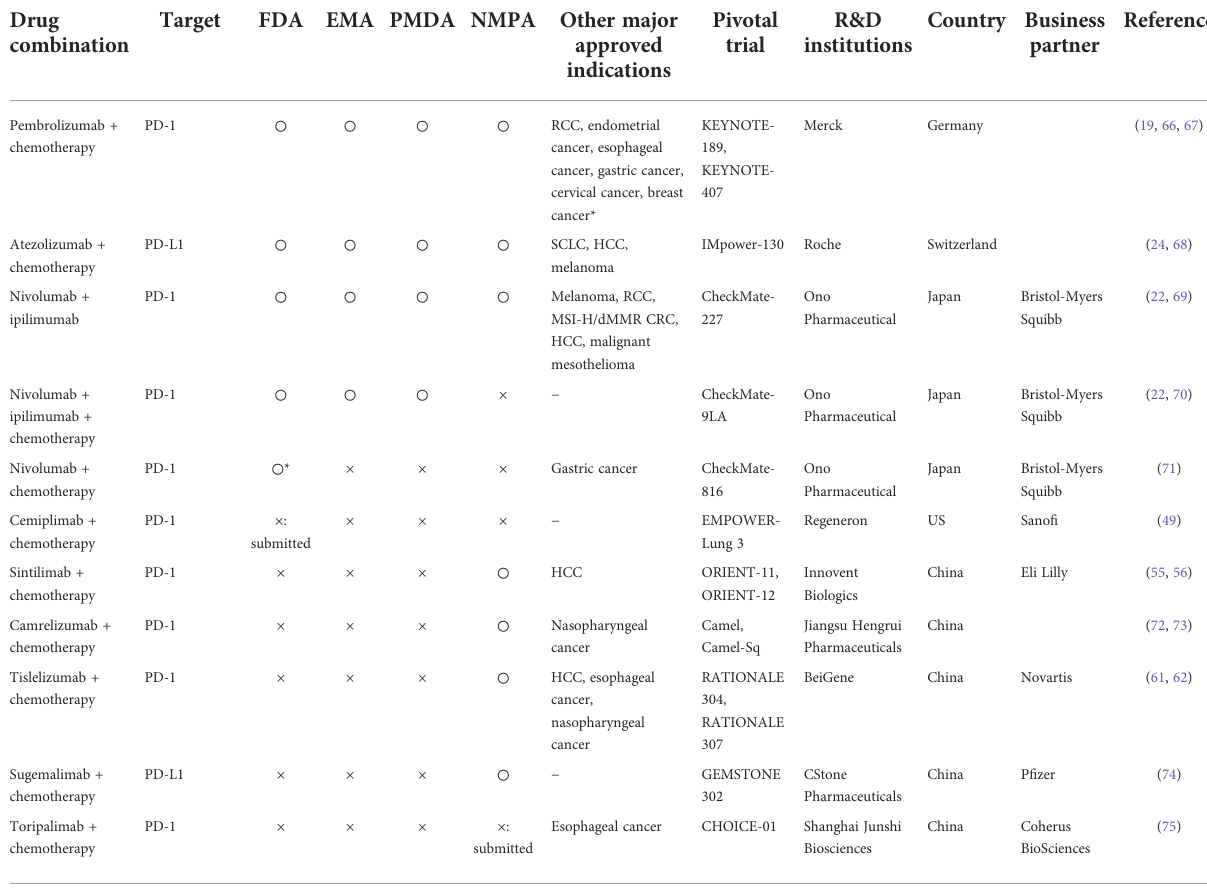
TABLE 2 Anti-PD-1/PD-L1 antibody combination therapy currently approved and under development (data on March 31,